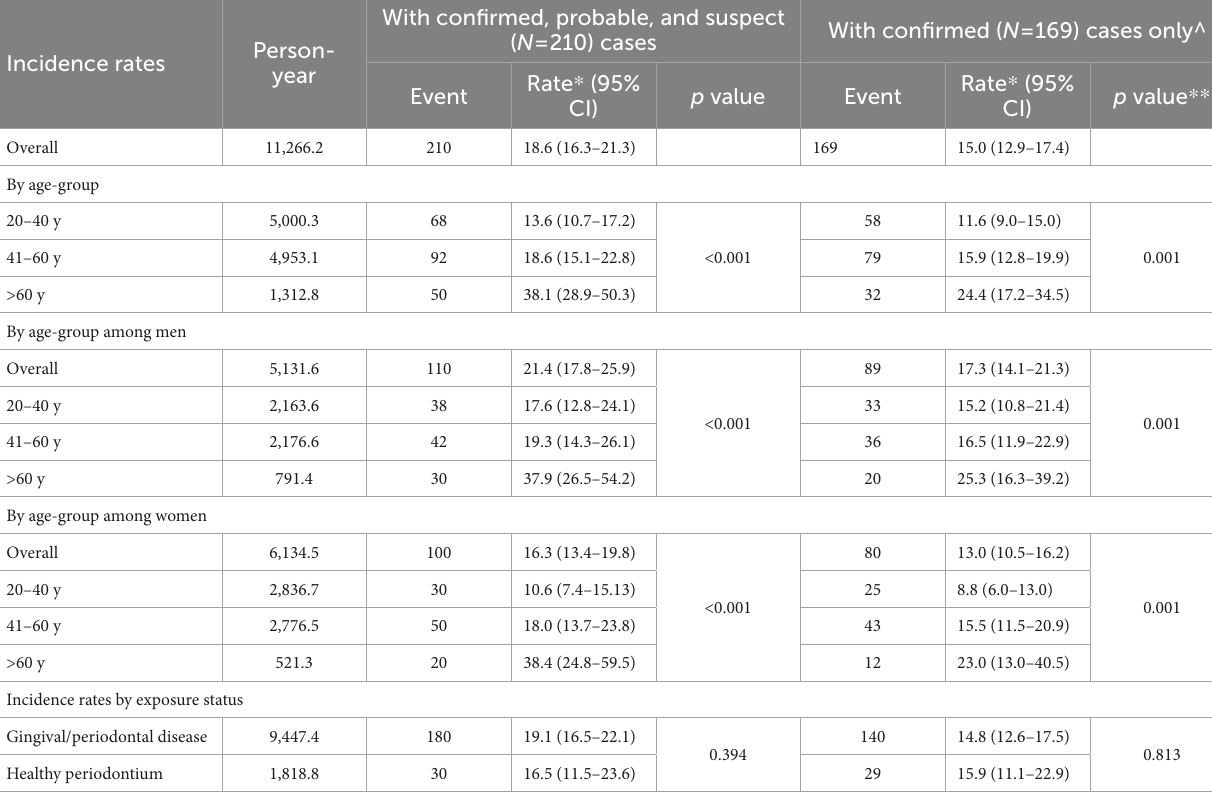
TABLE 3 COVID-19 incidence rates (per 1,000) by age, gender, and exposure status ( N = 1,727).